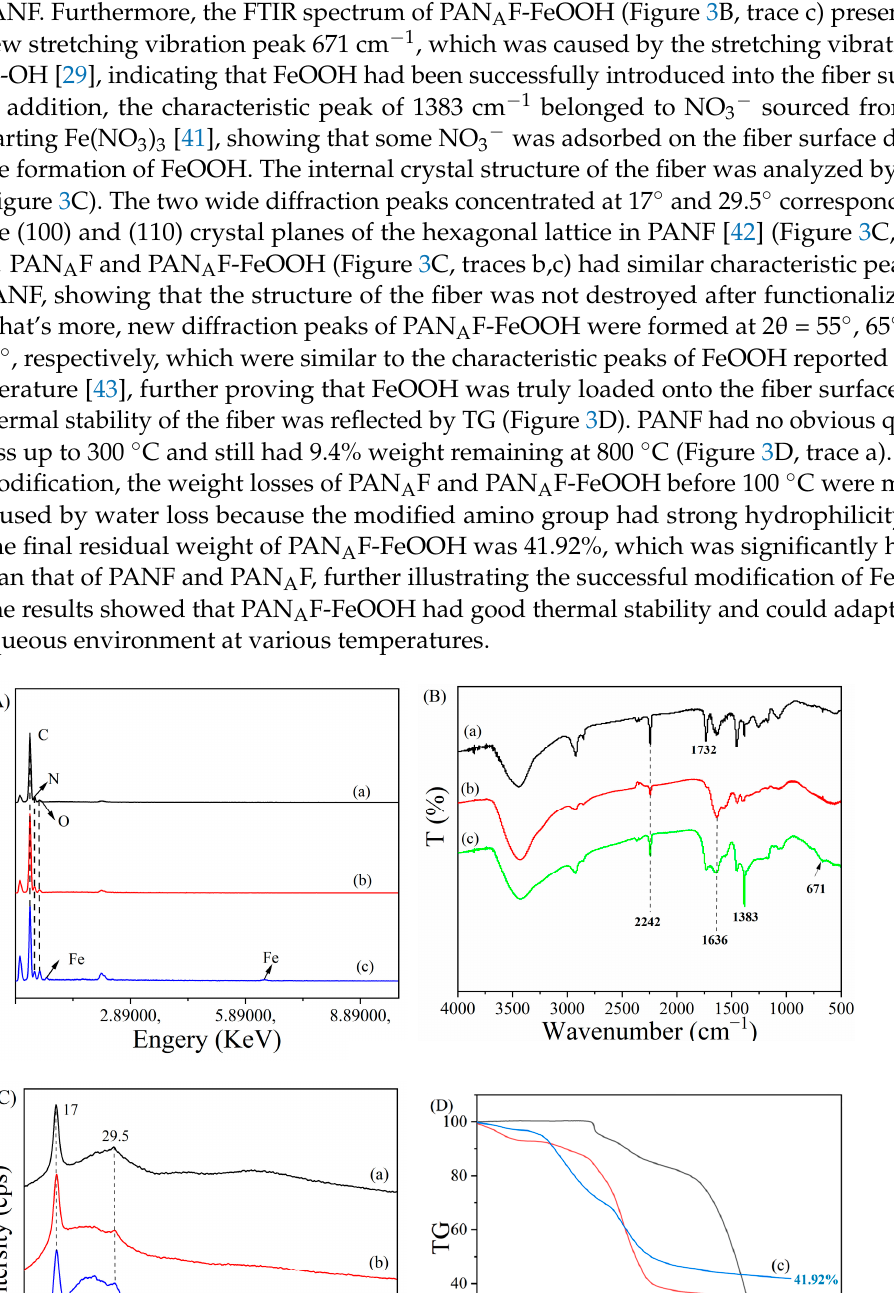
Figure 3. ( A ) The EDS spectra of (a) PANF, (b) PAN A F, and (c) PAN A F-FeOOH; ( B ) The FTIR spectra of (a) PANF, (b) PAN A F, and (c) PAN A F-FeOOH; ( C ) The XRD patterns and ( D ) TGA spectra of (a) PANF, (b) PAN A F, and (c) PAN A F-FeOOH. Elemental Analysis (EA)